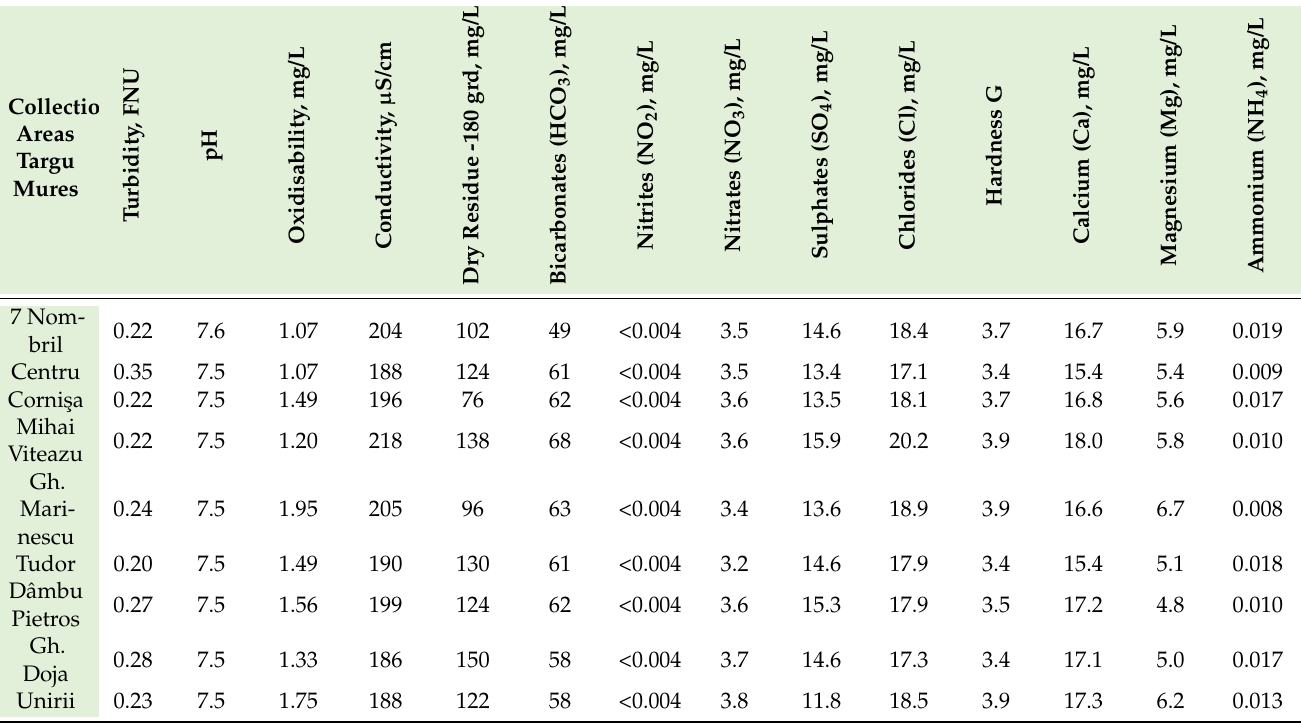
Table A1. Physico-chemical parameters of drinking water from the Water Distribution Operator in Mures County ,